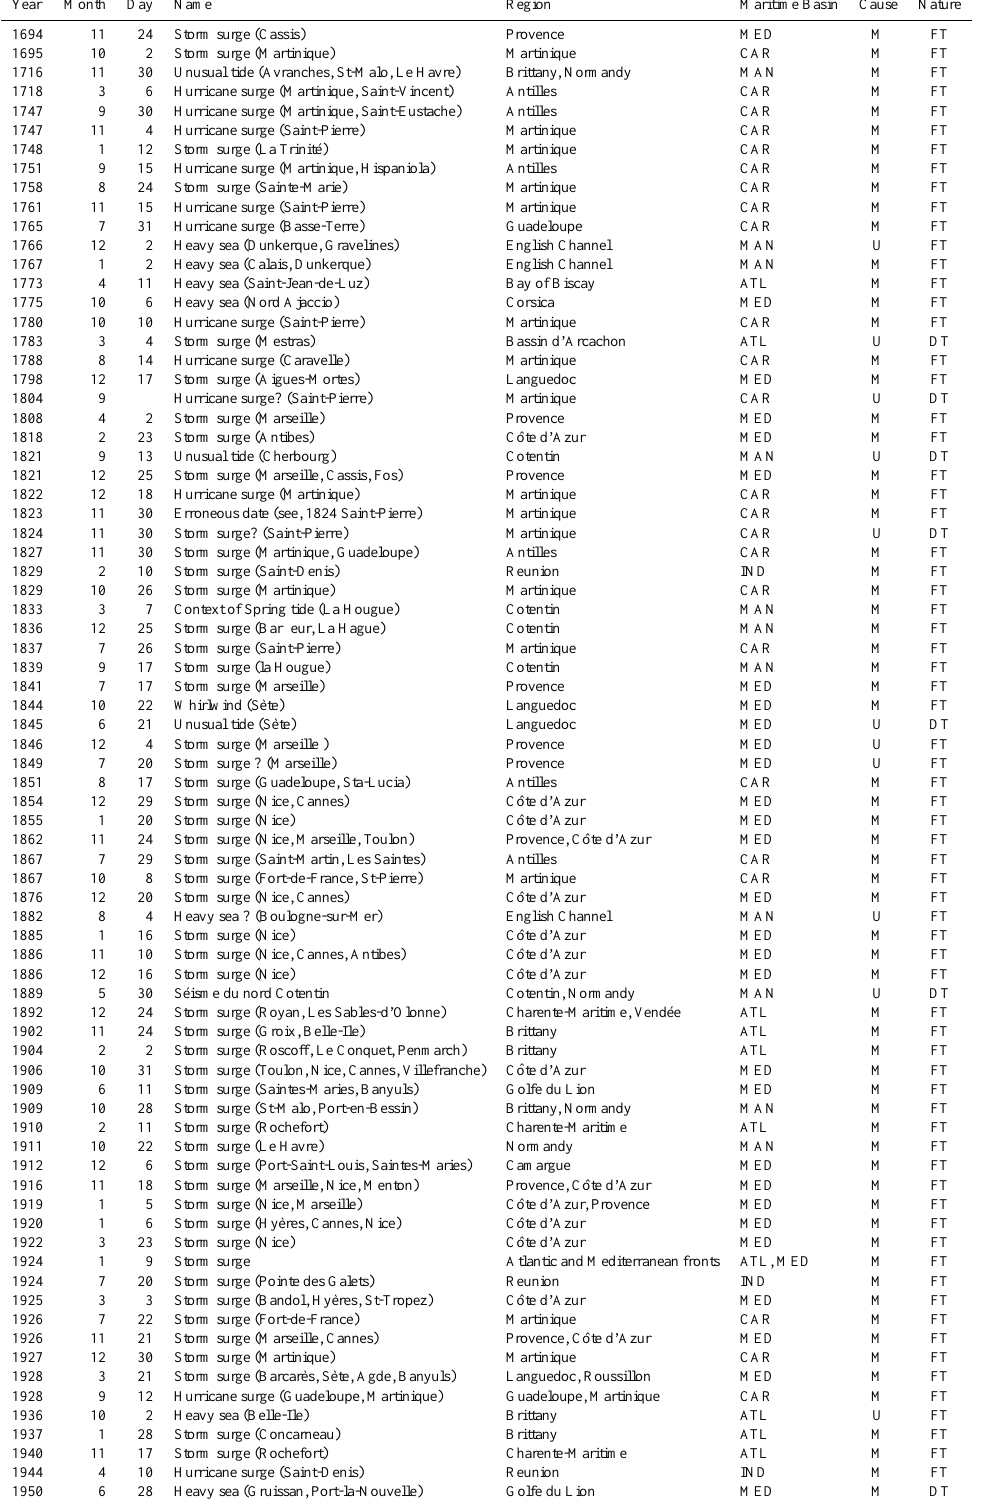
Table 2. “Events described as “raz-de-mar´ee” (tidal waves) and considered as “False” (FT) or “Doubtful”(DT) tsunamis (see Table 1 for legend). State of knowledge